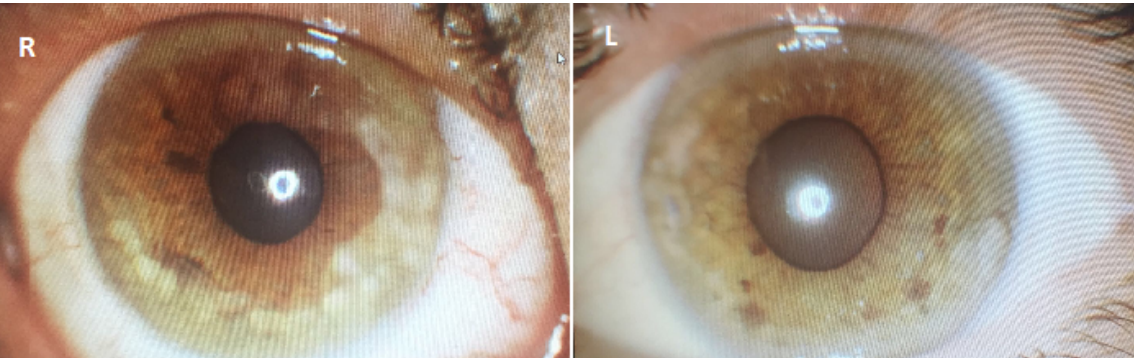
Figure 2: Stromal scar in peripheral cornea of both eyes after 3 weeks of treatment. There was no corneal neovascularization and corneal epithelial